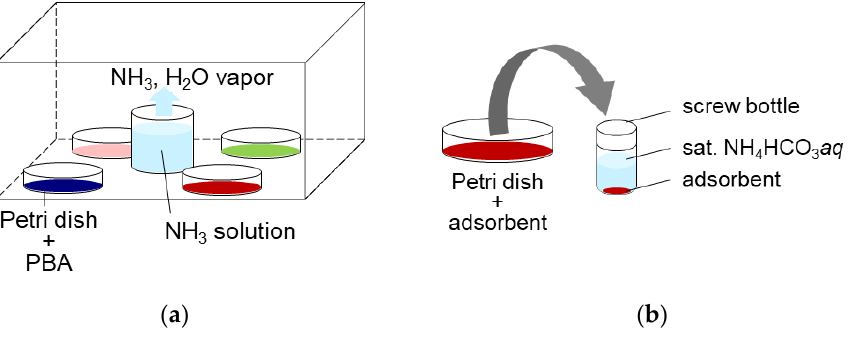
Figure 11. ( a ) The adsorption method. ( b ) The desorption